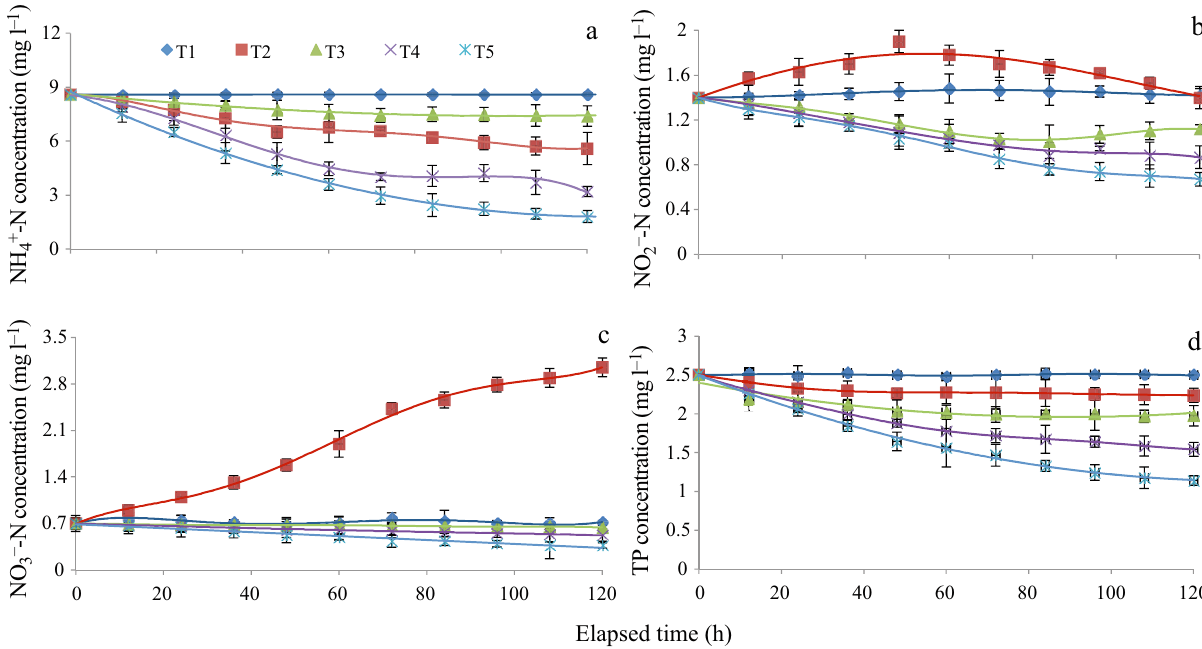
Fig. 4. Removal of NH 4+ -N, NO 2 − -N, NO 3 − -N and total phosphorus (TP) in aquacultural sewage by control treatment (T1), ef- fective microorganisms (T2), prepared maize straw biochar (T3), unfixed ammonia nitrogen and phosphate removal strains (ANRS and PRS) (T4) and biochar-immobilized ANRS and PRS (T5) in laboratory experiments. Error bars: